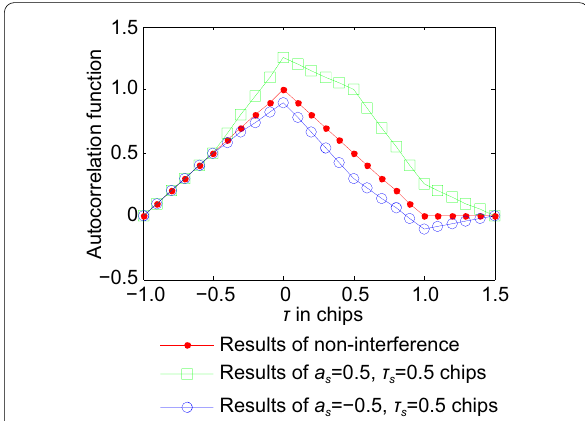
Fig. 1 Autocorrelation function curve under different interference forms. The red curve shows the autocorrelation function without interference. The green curve demonstrates the autocorrelation function distorted by an in-phase NLOS signal. The blue curve exhibits the autocorrelation function distorted by an out-of-phase NLOS